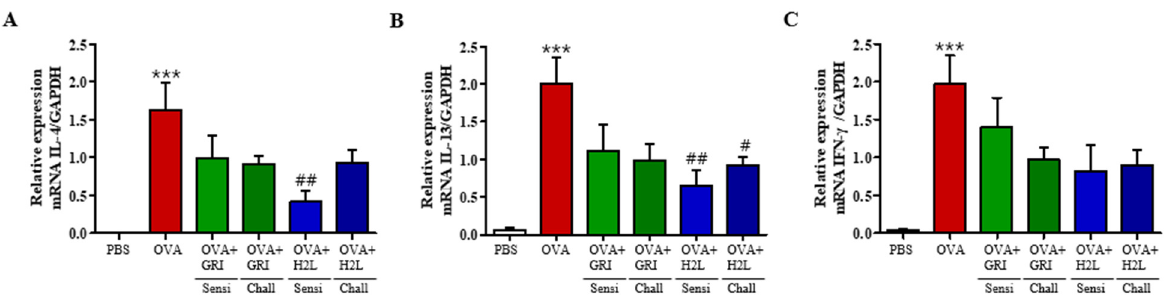
Figure 5. H2L5186303 and GRI977143 inhibit the mRNA expression of cytokines in the BALF cells. Analysis of mRNA expression of the Th2 cytokines IL-4 and IL-13 and the Th1 cytokine IFN- γ in BALF cells. ( A ) IL-4, ( B ) IL-13, and ( C ) IFN- γ levels. The relative mRNA levels of cytokines were quantified with respect to glyceraldehyde-3-phosphate dehydrogenase (GAPDH) as the housekeeping gene. Values are presented as the mean ± standard error (SE) ( n = 5). *** p < 0.001 vs. the PBS-treated group, # p < 0.05, ## p < 0.01 vs. the OVA ‐ treated group.